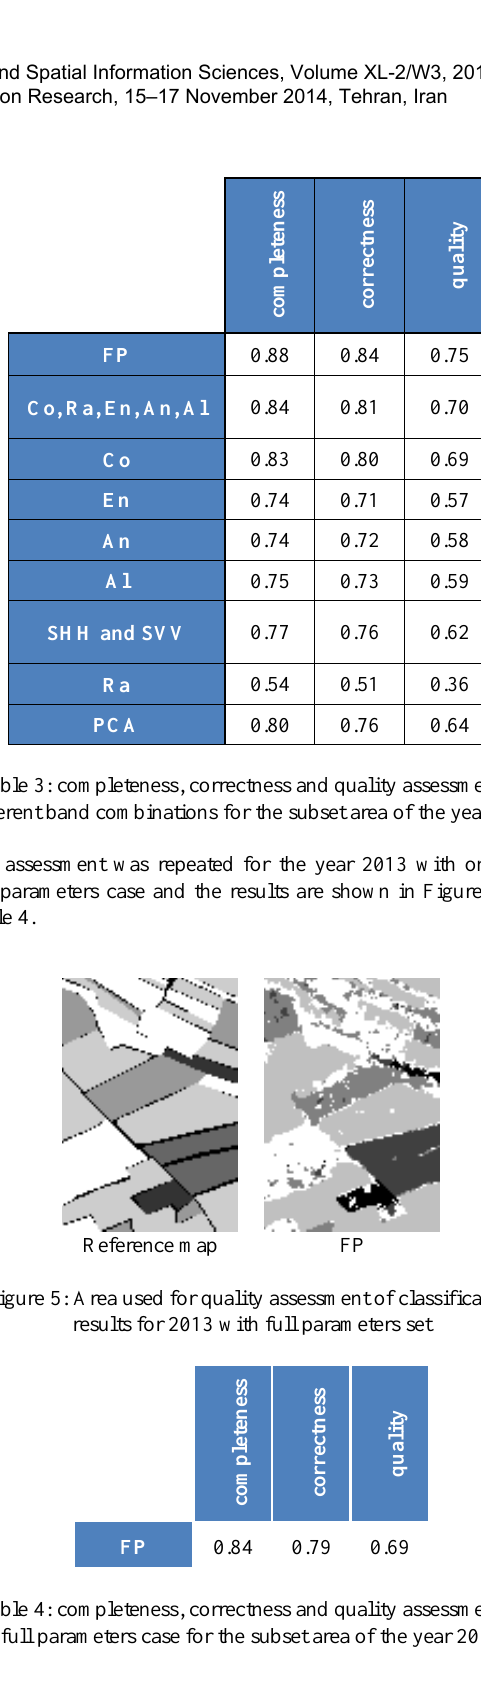
Figure 4: classification results of the subset area for quality assessment with the specified band combination written under each figure (for the year 2012)